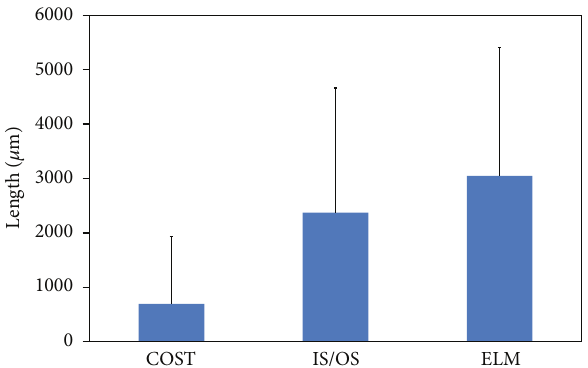
Figure 2: Mean lengths of the cone outer segment tips (COST), photoreceptor inner and outer segment (IS/OS) junction, and external limiting membrane (ELM) lines in 133 eyes with retinitis pigmentosa. The ELM length was significantly longer than the IS/OS or COST length, and the IS/OS length was significantly longer than the COST length (all 𝑃 < 0.0001 ). Error bars represent one standard deviation from the